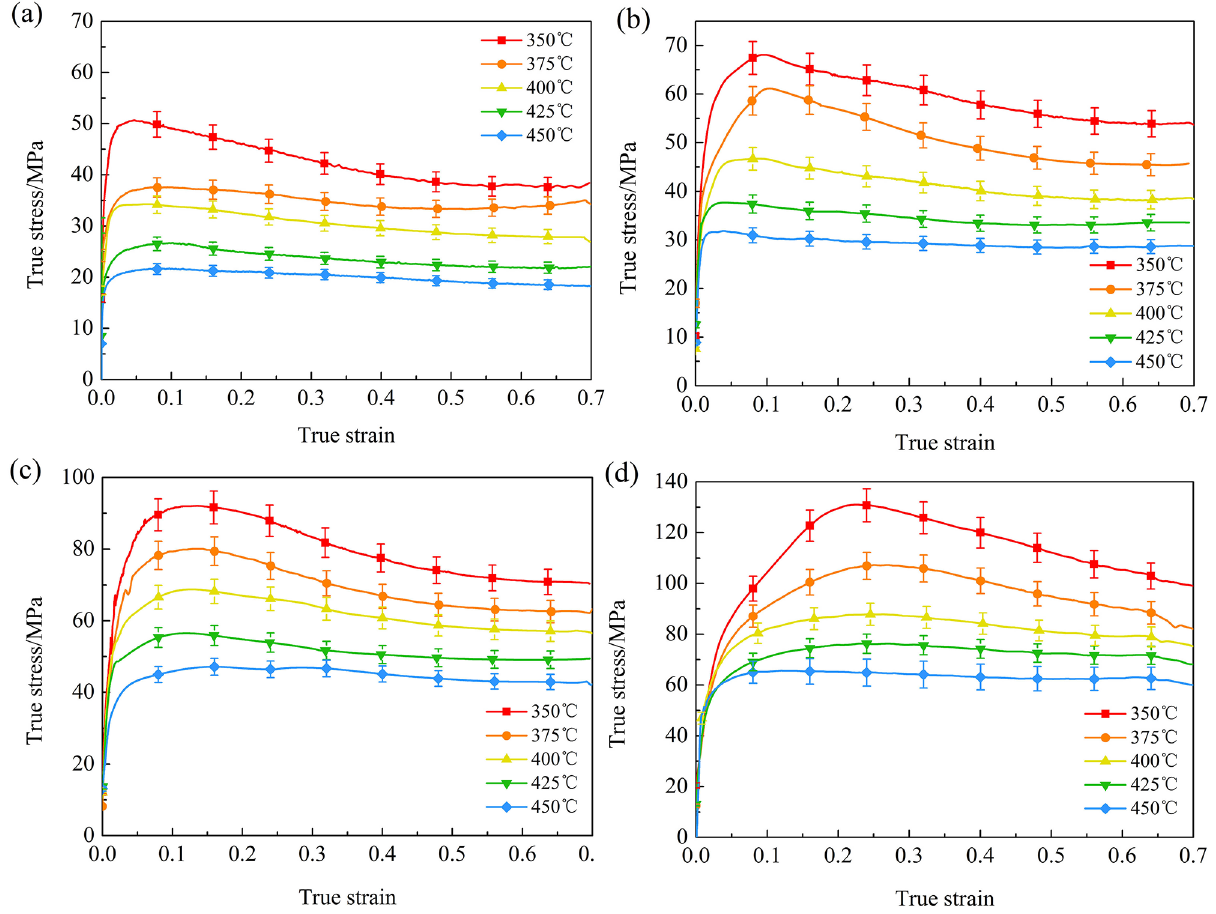
Fig. 3. Hot compression results of AZ61 magnesium alloy: (a) _ e = 0.001 s (cid:1) 1 ; (b) _ e =0.01 s (cid:1) 1 ; (c) _ e =0.1 s (cid:1) 1 ; (d) _ e = 1 s (cid:1) 1